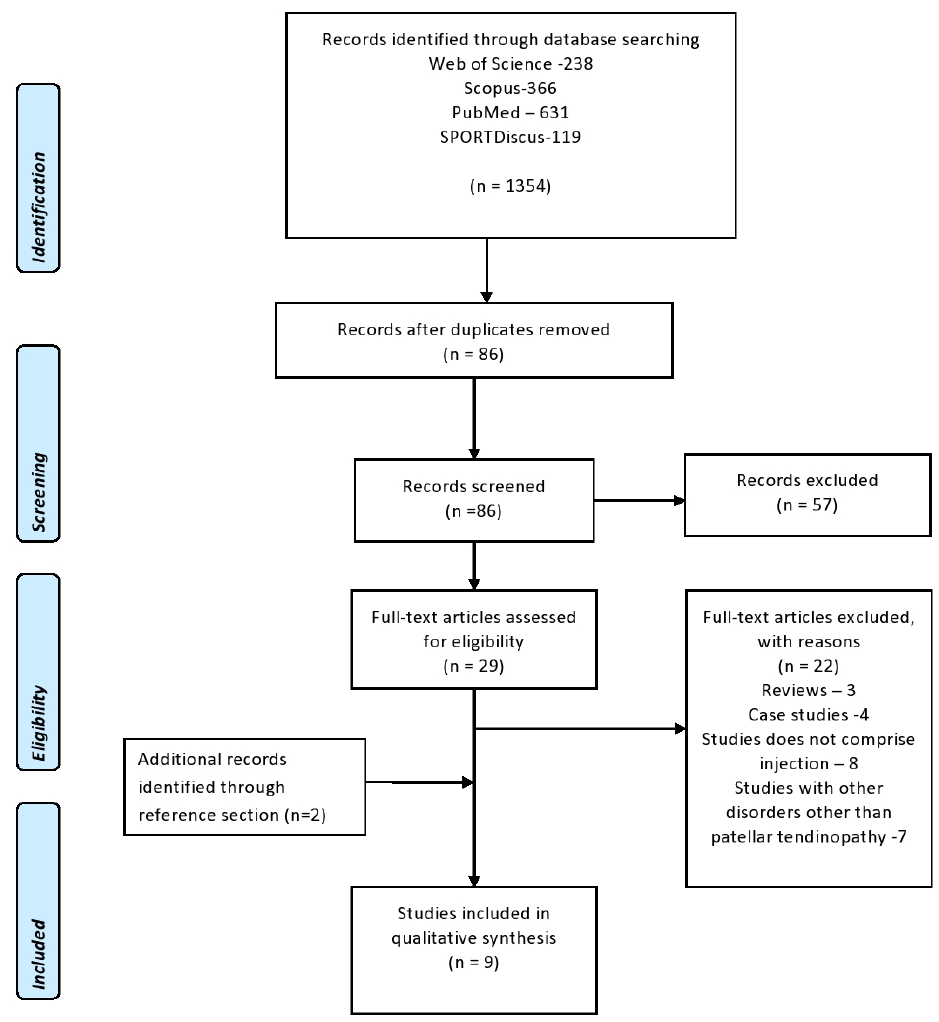
Figure 1. PRISMA flow diagram regarding the selection and screening of the article.